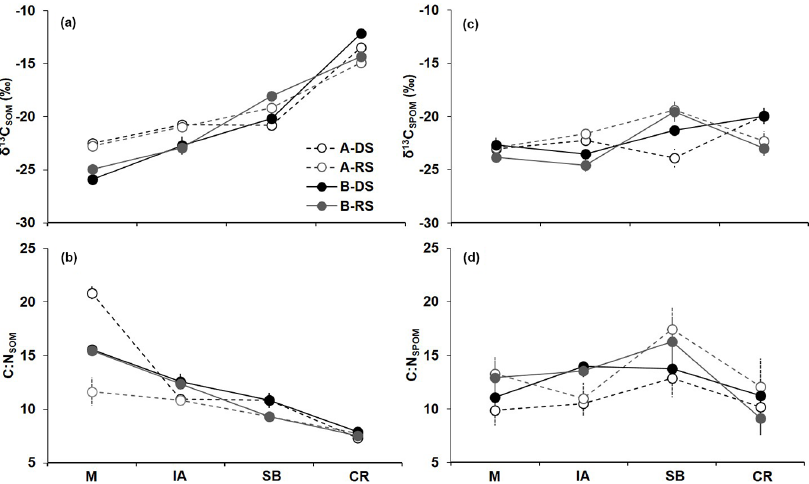
Figure 3. δ 13 C (‰) and C:N ratio of sedimentary organic matter (SOM; a, b ) and suspended particulate organic matter (SPOM; c, d ) from the four sampling stations (mangrove forest, M; intertidal area, IA; seagrass bed, SB; coral reef, CR). Transects A and B are indicated with open and filled circles respectively. Dry (DS) and rainy seasons (RS) are indicated in black and grey circles